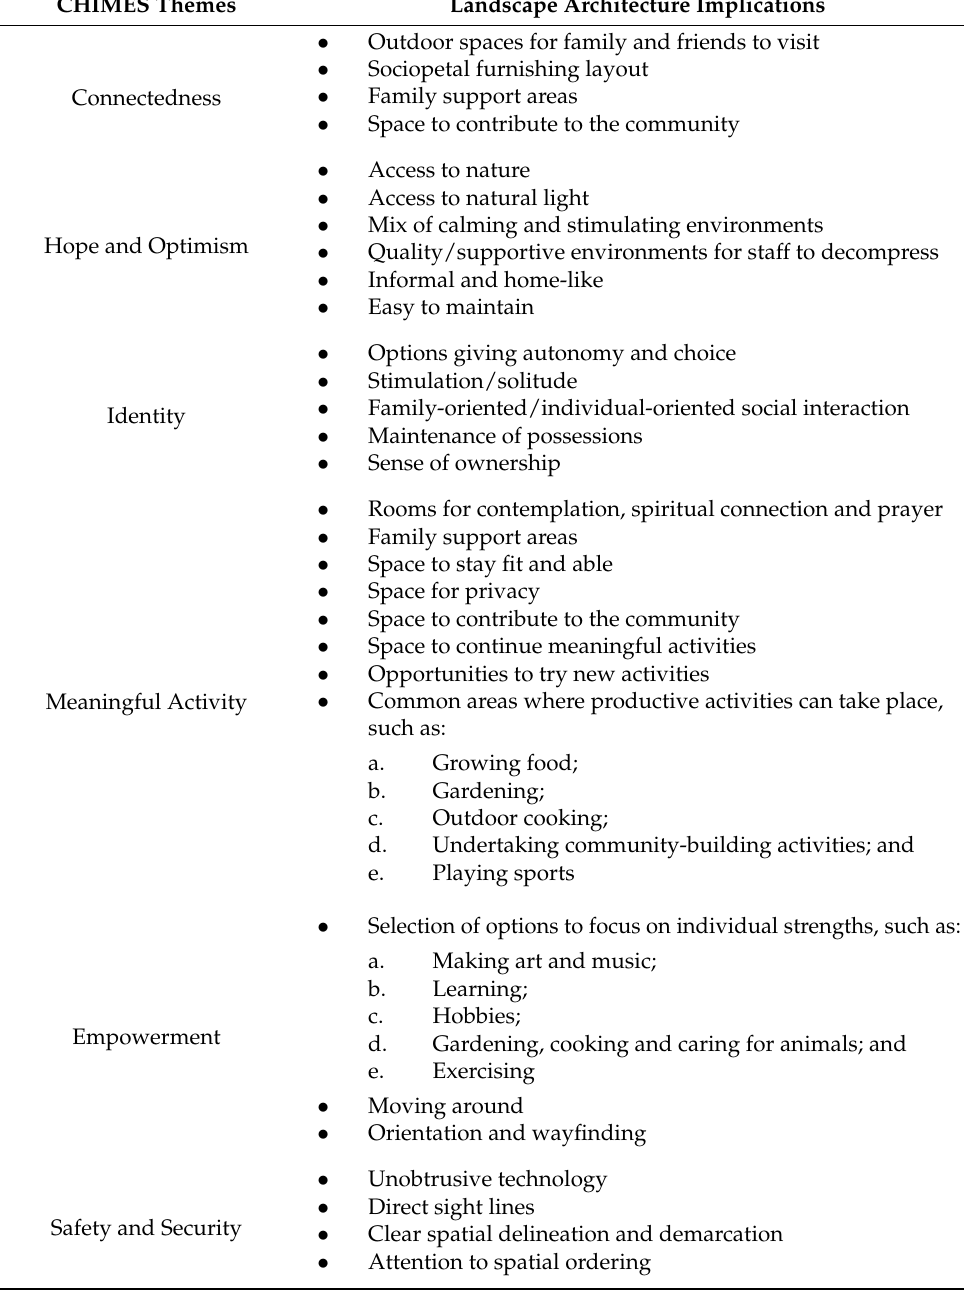
Table 4. List of needs that courtyard design must accommodate (adapted from [13]). CHIMES